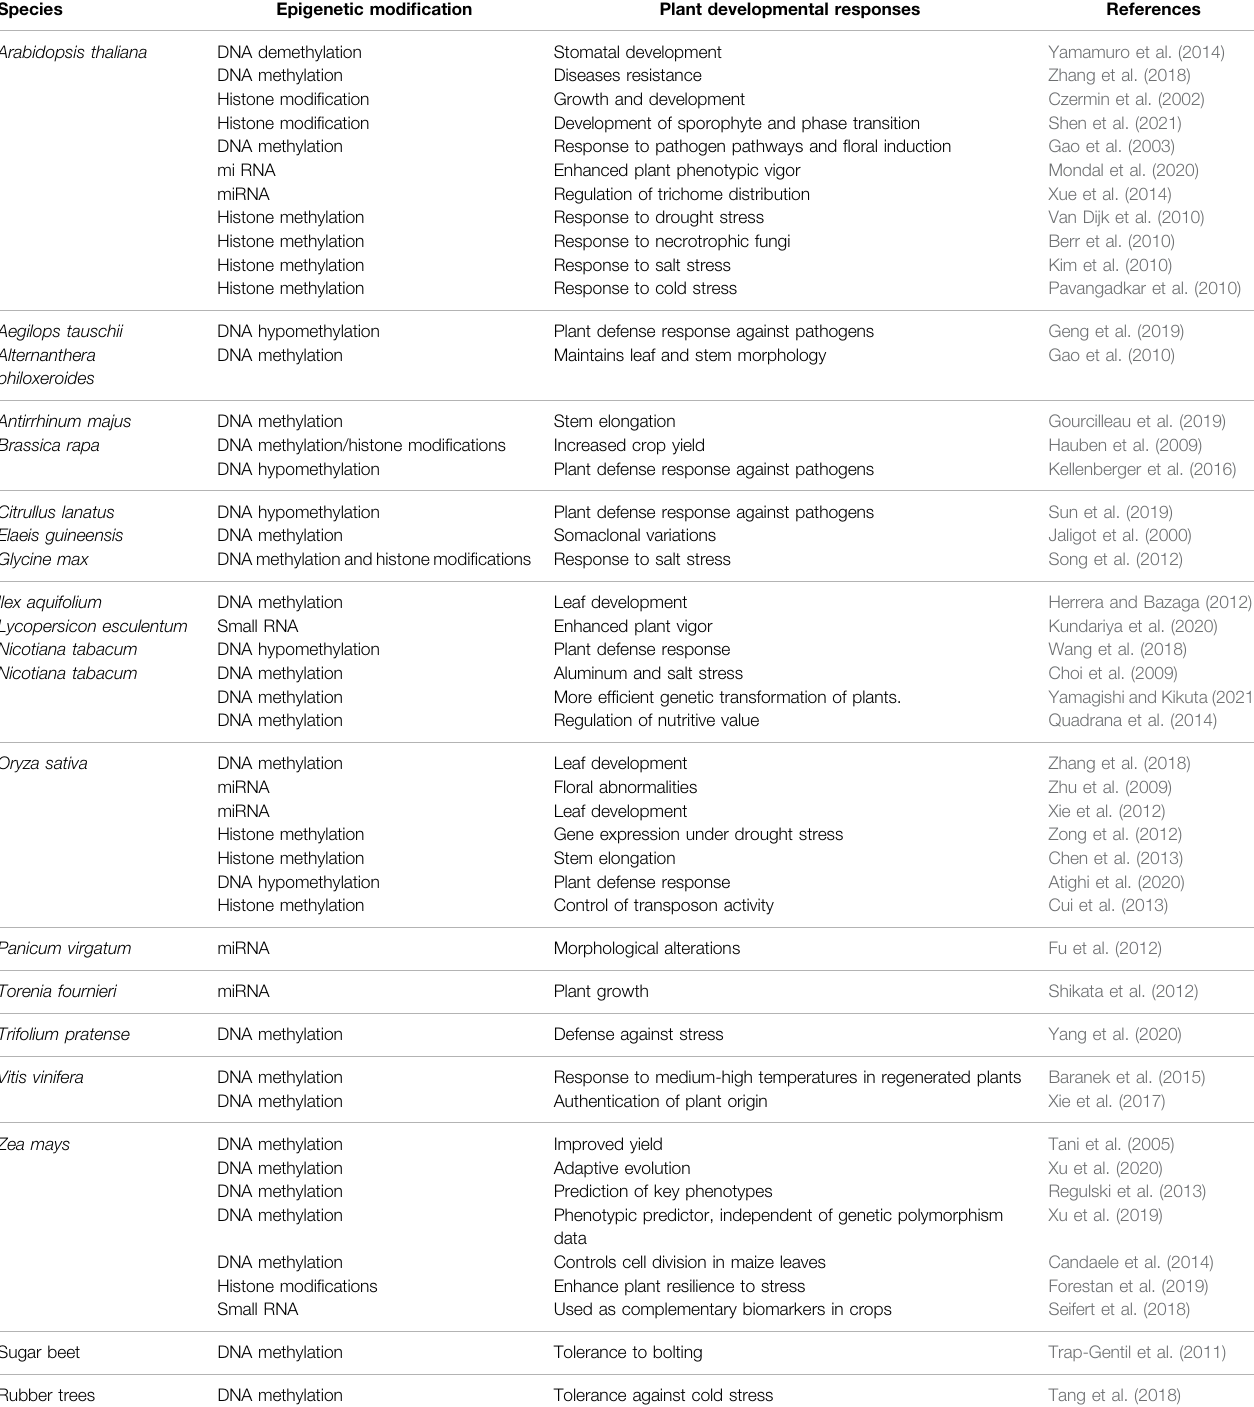
TABLE1 | Role of epigenetically induced modi fi cations in trait control, development, and morphogenesis of different plant species.